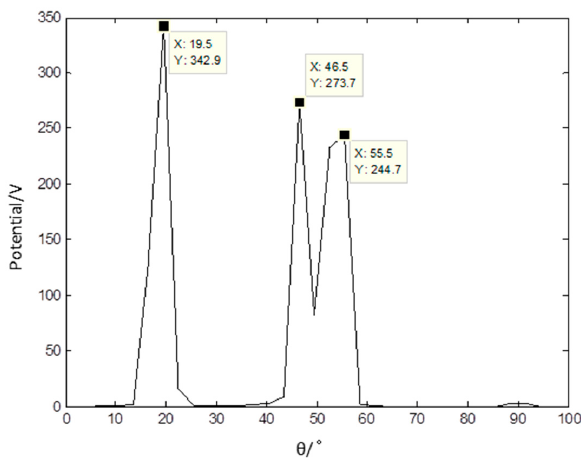
Figure 11. Potential function of sparse signals based on the proposed method.